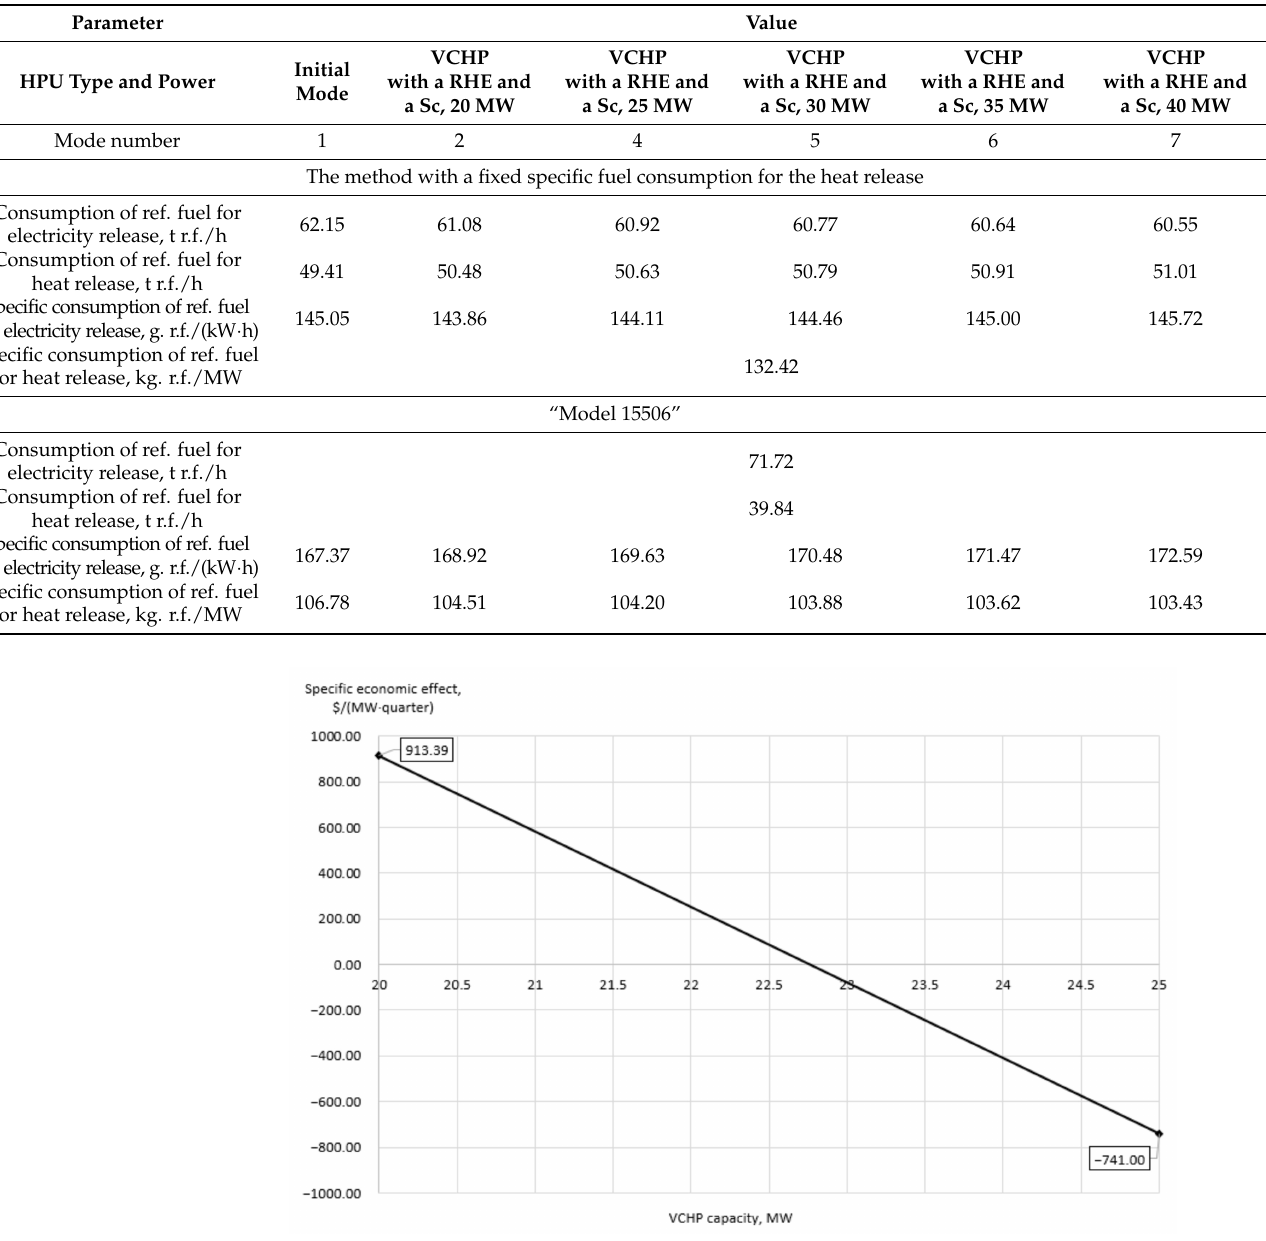
Table 11. Winter mode simulation results of using HPUs for heating make-up water with a flow rate of 1500 t/h.